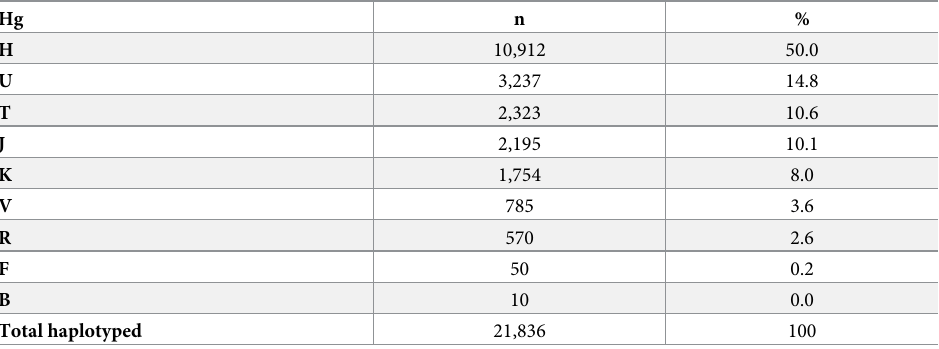
Fig 3. PCA of the macro-haplogroups L, M, N and R. PC1: First principal component. PC2: Second principal component. https://doi.org/10.1371/journal.pone.0208829.g003 Table 2. Distribution of mtDNA haplogroups constituting the macro-hg